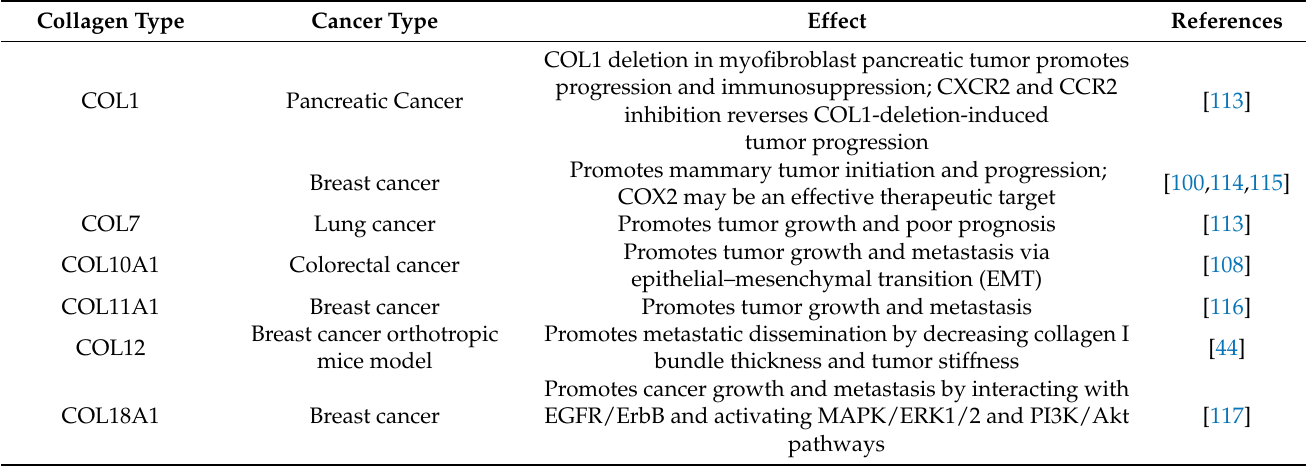
Table 2. In vivo studies focused on the collagen